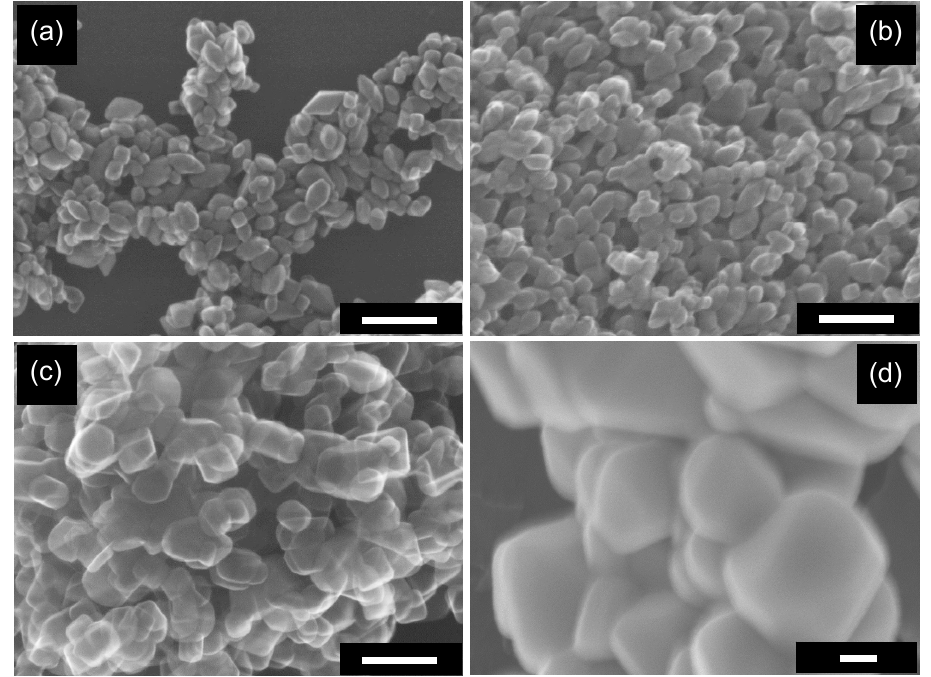
Figure 4. SEM images of OAPs with calcination temperatures of ( a ) 673 K; ( b ) 873 K; ( c ) 1073 K and ( d ) 1173 K. Scale bar: 100